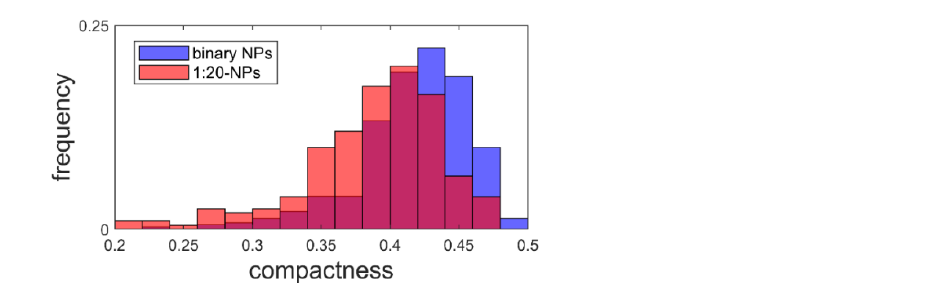
Figure 7. The compactness of proticles with ( N = 200) and without ( N = 369) citric acid supplementation.